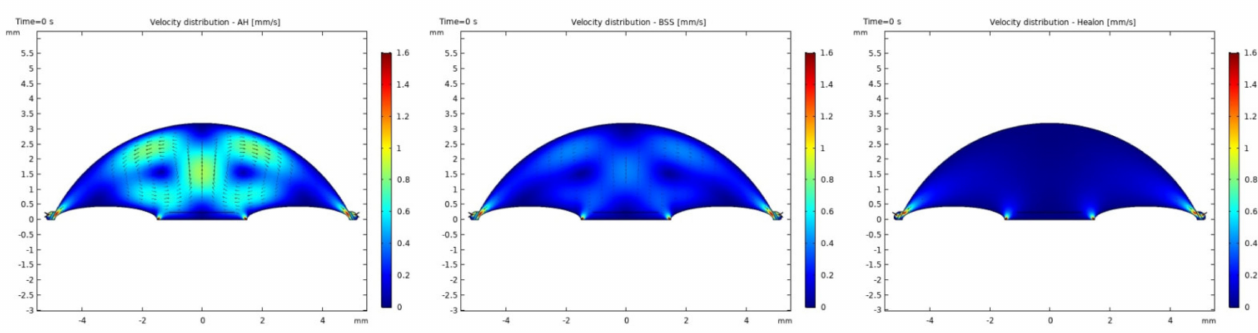
Figure 4. Initial velocity distributions with AH, BSS and Healon.